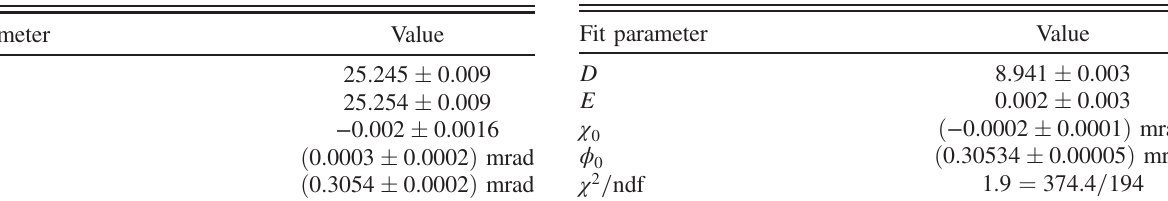
TABLE VII. Parameters of the fit shown in Fig. 22(b). The fit parametrizes the simulated data shown in Fig. 20(a), using Eq. (115) and F ¼ 10 20 .